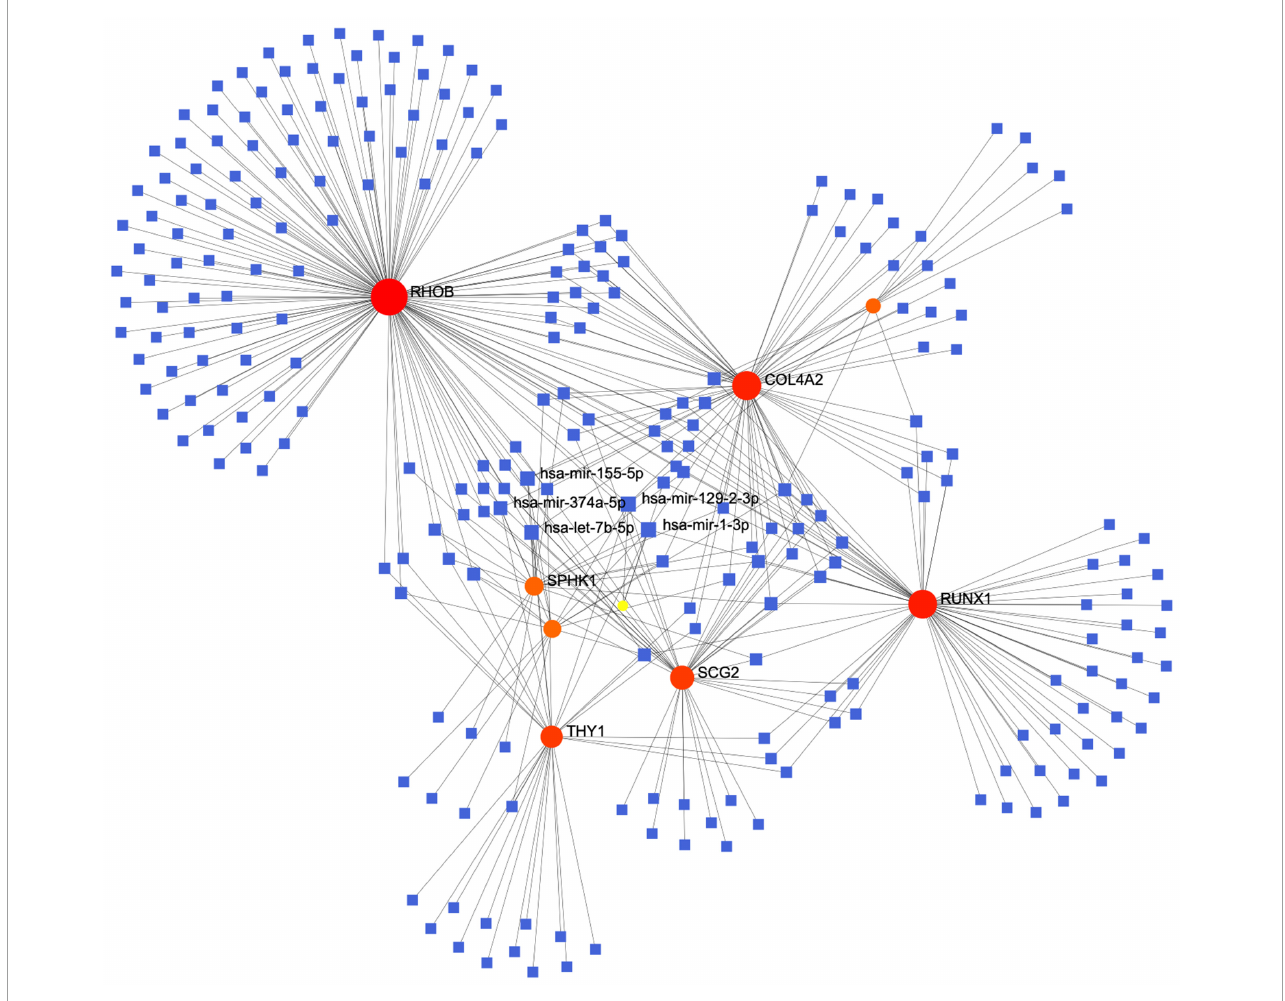
FIGURE5 The protein-miRNA interaction network diagram, in which the blue squares represent miRNAs, the orange origins represent the related genes we screened out, with the top five miRNAs with the highest comprehensive scores displayed.